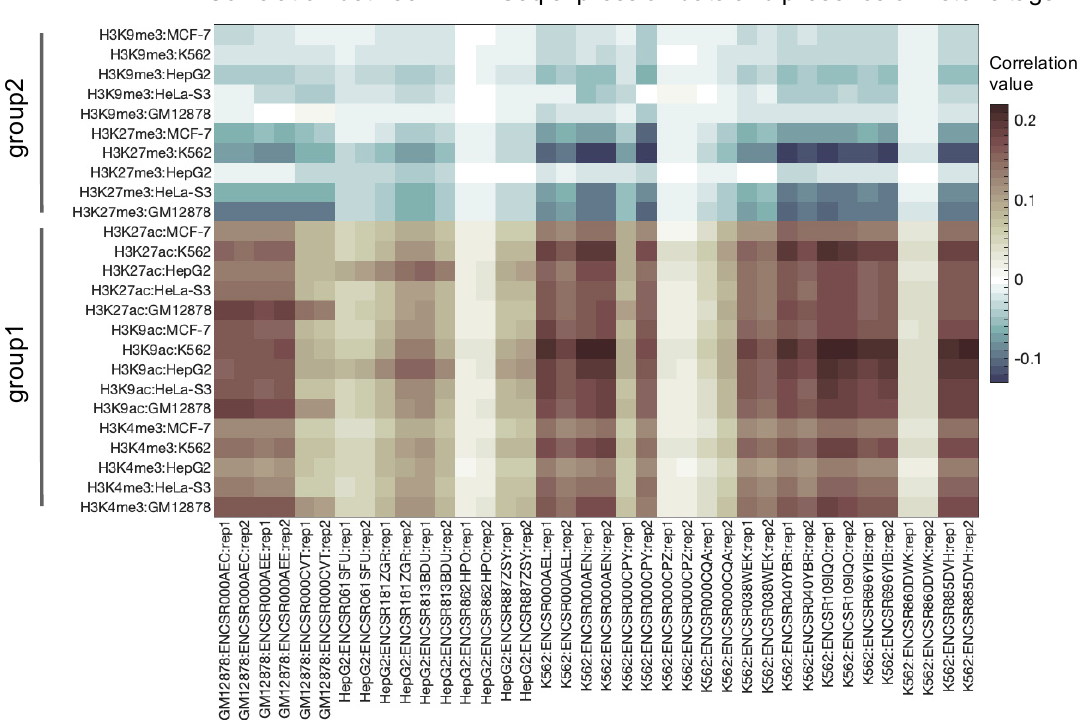
Figure 2. Correlations of histone profiles with the RNA sequencing gene expression profiles available in ENCODE database.